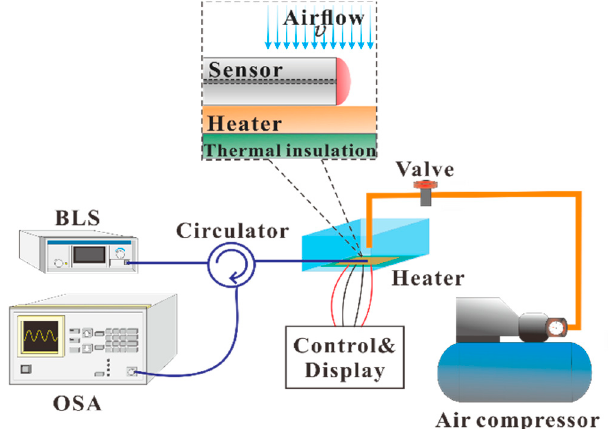
Figure 5. Experimental setup for measuring speed of airflow.